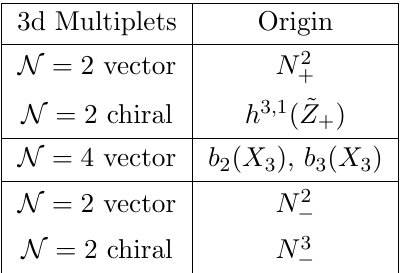
Table 1 . Subsectors with enhanced supersymmetry and their topological origin. The N = 4 vector multiple from the neck region is only massless in the in(cid:12)nite neck limit and away from this becomes an N = 1